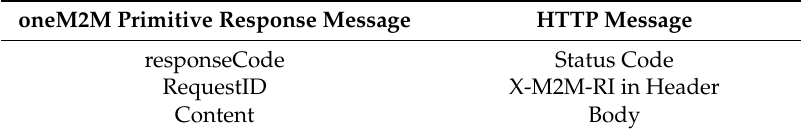
Table 2. Mapping between oneM2M primitive Response messages and HTTP messages.